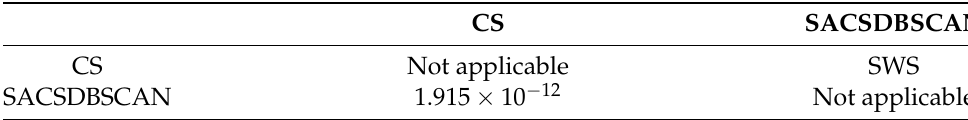
Table 16. p -values for instance NRE.5.